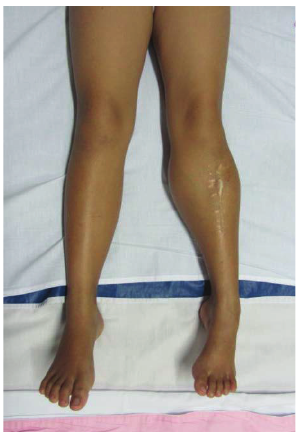
Figure 9: Clinical picture of the mass on lateral side of left lower leg in Case 3.